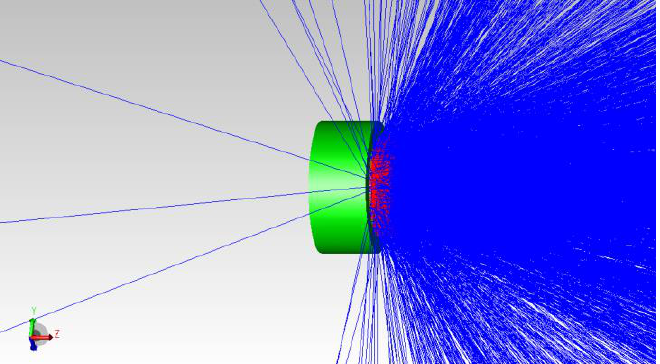
Figure 2. Irradiation distribution model on the catalyst surface and in the